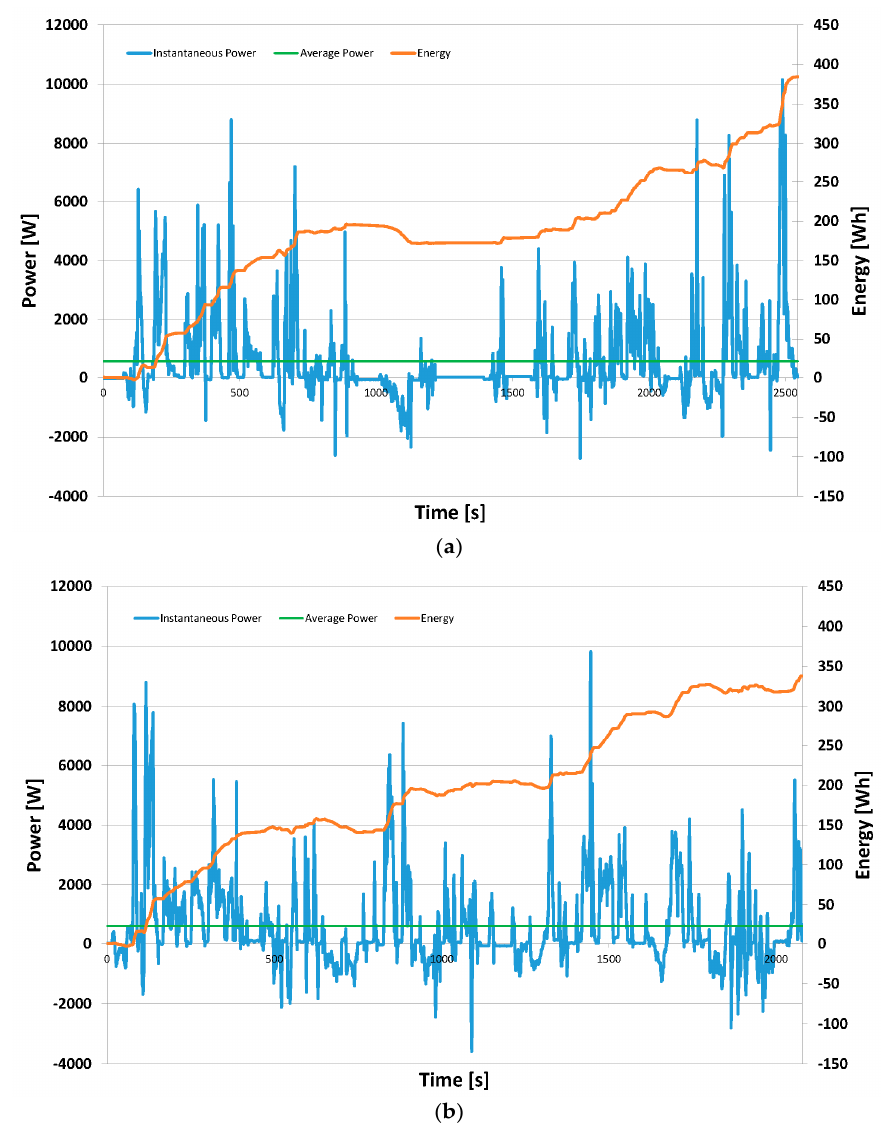
Figure 6. Typical result in the standard testing route for Traction Power (blue), Average Power (green), and energy consumed (orange). ( a ) Route 1; ( b ) Route 2.